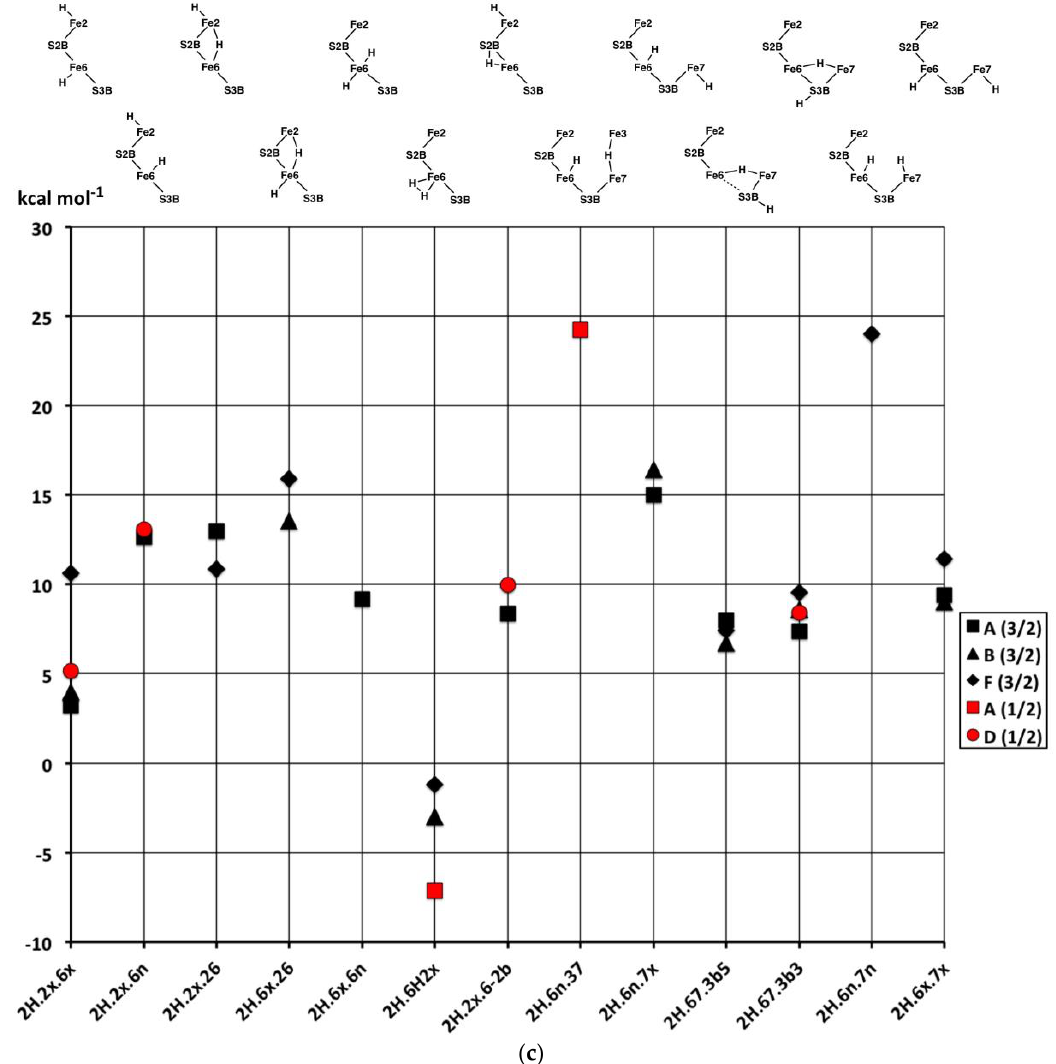
Figure 6. Relative potential energies (kcal mol −1 ) of the optimised structures with two H atoms bonded to FeMo-co, in their most stable electronic/spin states. The three parts of the figure have the same energy reference. The tie lines are included only as a visual guide. Black symbols are S = 3/2 states, red symbols are S = 1/2 states. ( a ) Energies for the sequence of structures in Figure 5a. ( b ) Energies for the sequence of structures in Figure 5b. ( c ) Energies for the sequence of structures in Figure 5c,d.